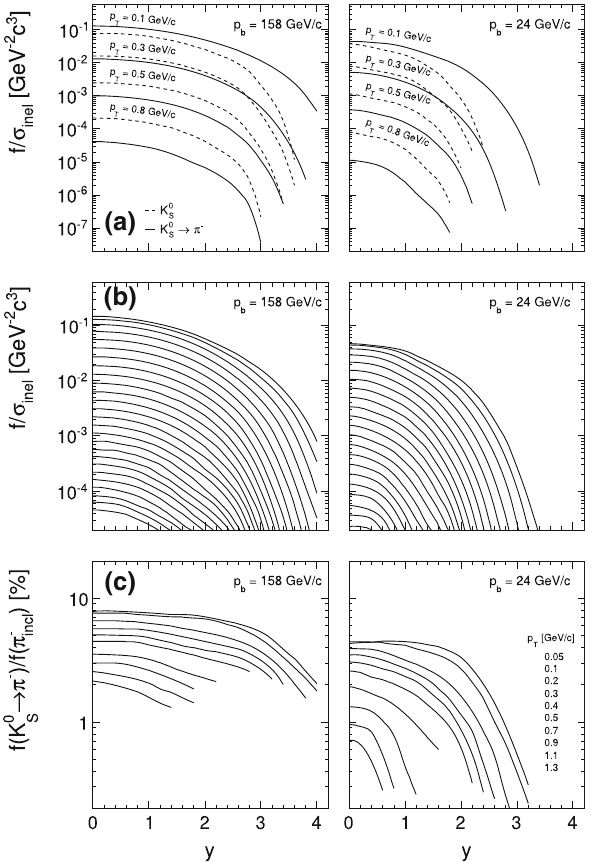
Fig. 16 a Invariant π − cross section f /σ inel as a function of y for four values of p T at 158 and 24 GeV/c beam momentum. Full lines for π − andbroken linesfortheparent K 0 .Subsequent p T values aremultiplied S decay as by 1/3 for clarity; b invariant π − cross section f /σ inel from K 0 S a function of rapidity for p T between 0.05 and 1.3 GeV/c; c percentage ratio of π − from K 0 decay to the inclusive, feed-down subtracted π − S yield